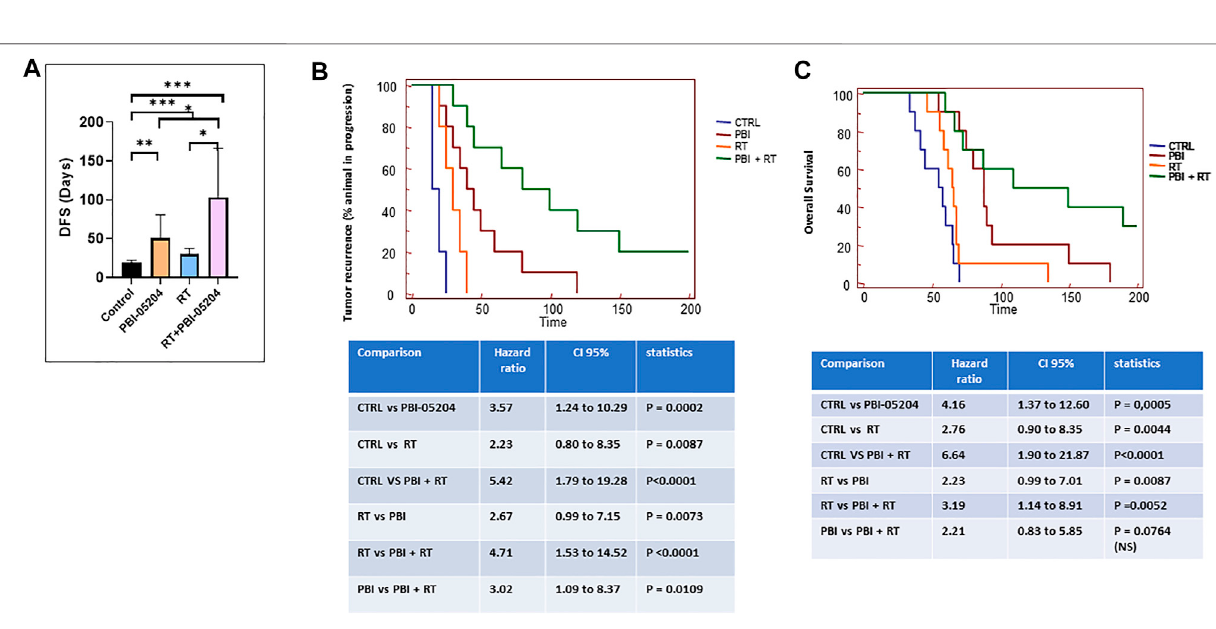
individual treatment modality ( Figure 7E ). The growth curve of both U251 and T98G mouse xenografts also further supports the radiosensitizing effect of PBI-05204 ( Supplementary Figure S4 ).